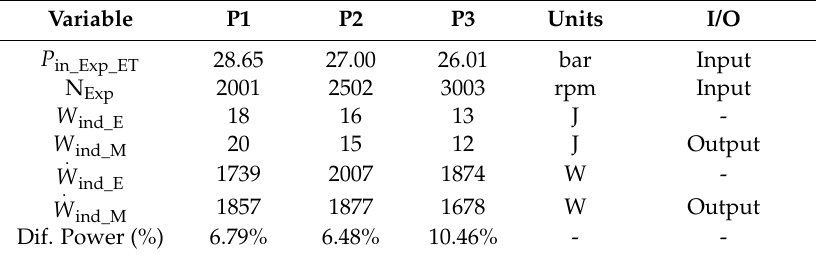
Table 8. Results of the swash-plate